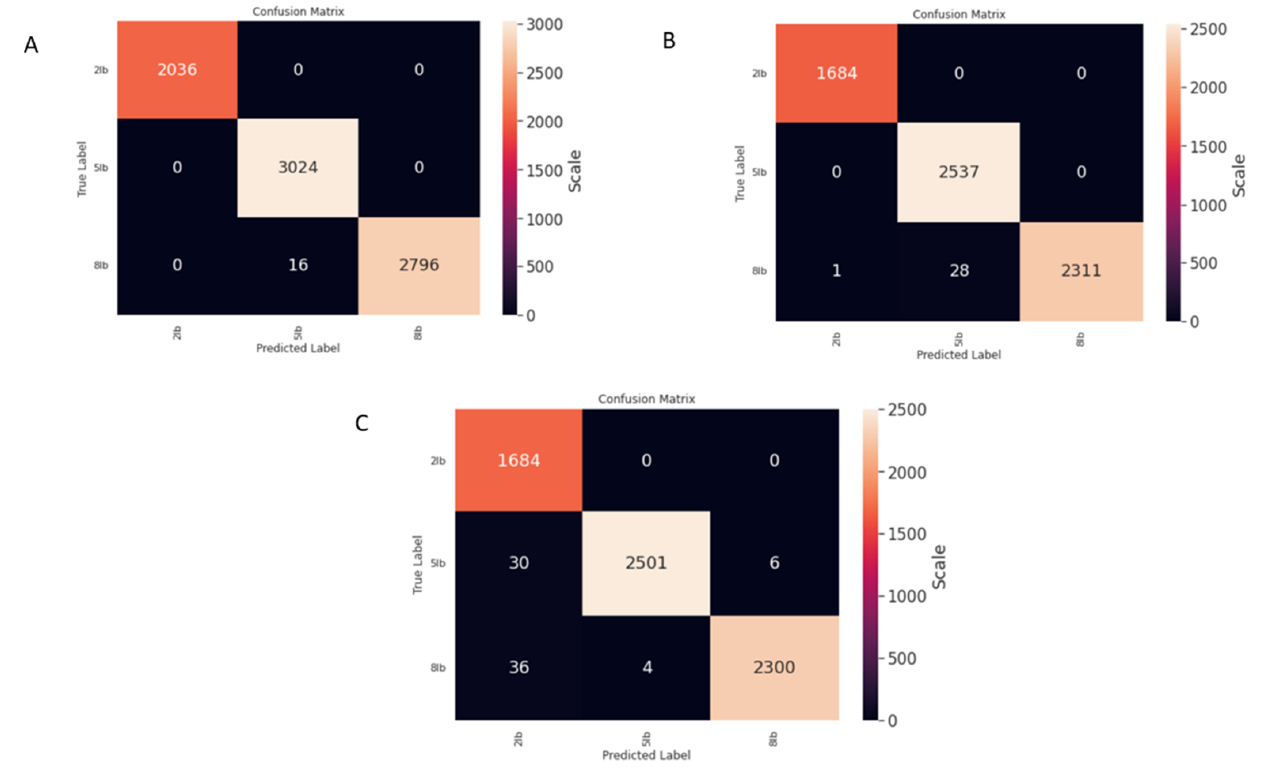
Figure 16. Evaluation metrics for all the developed models: ( A ) SVM, ( B ) MLP, ( C ) LDA.